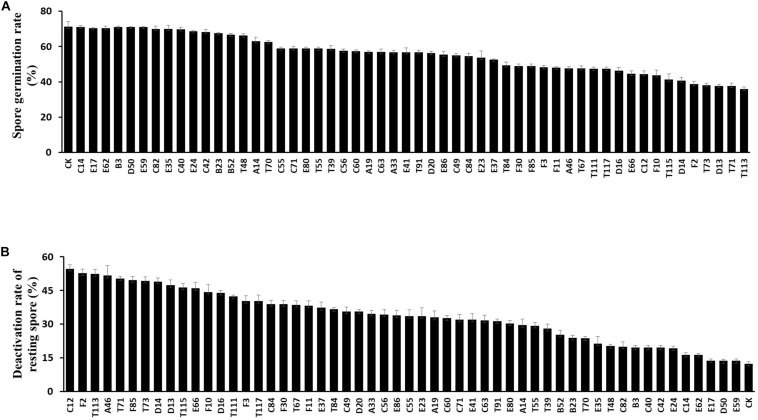
Inhibitory effect of antagonistic strains on the germination and viability of resting spores. (A) Resting spore germination rate of Plasmodiophora brassicae after treatment with biocontrol strains. Each experiment was repeated three times. Data are presented as mean ± SD. Capped lines represent standard errors. (B) Deactivation rate of resting spores of P. brassicae.